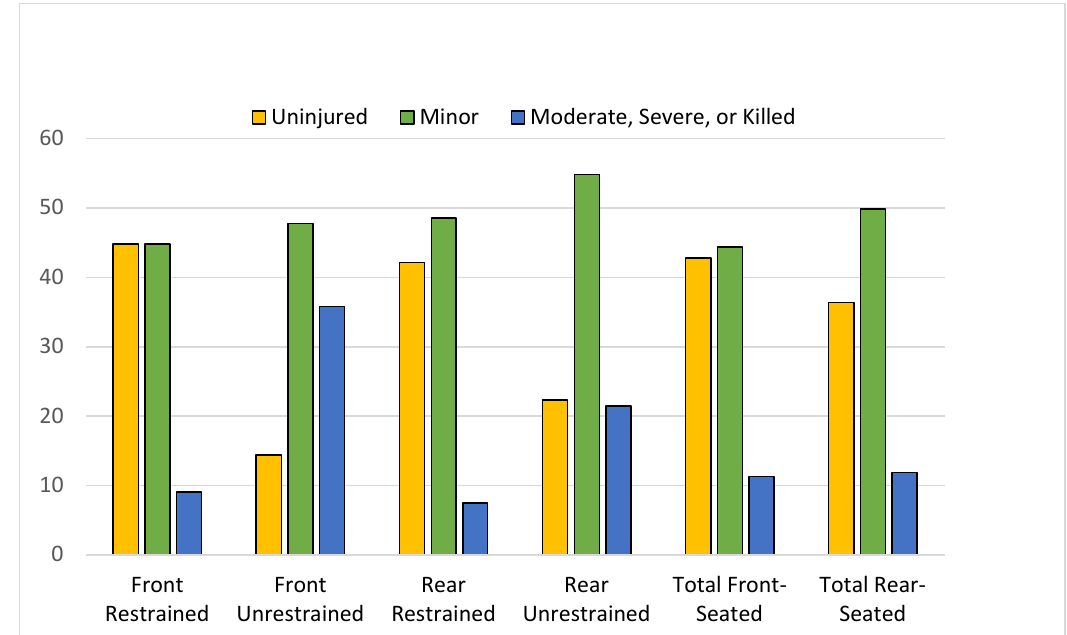
Figure 1. Injury severity is shown as the percent of occupants who sustained no injury (yellow), minor injury (green) and moderate or severe injury or died (blue) by seating position and restraint status with total front seated and total rear seated.